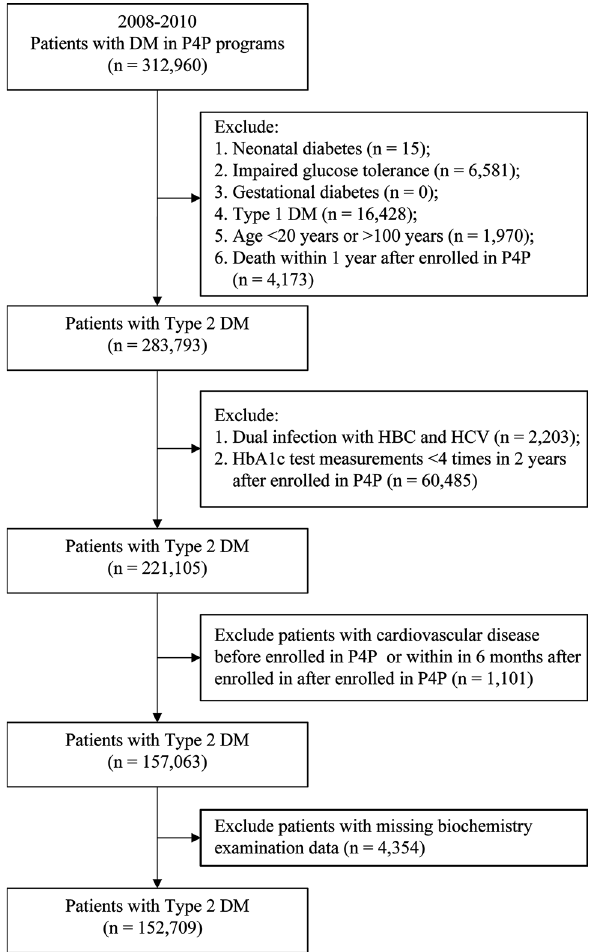
Figure 1. Flowchart for study subject selection. DM diabetes mellitus, P4P pay-for-performance, HBV hepatitis B virus, HCV hepatitis C